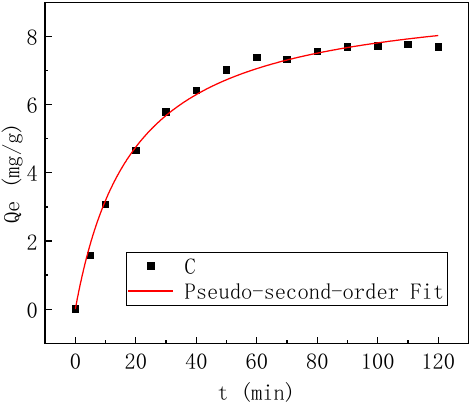
Figure 5. Pseudo-second-order adsorption kinetics fit.